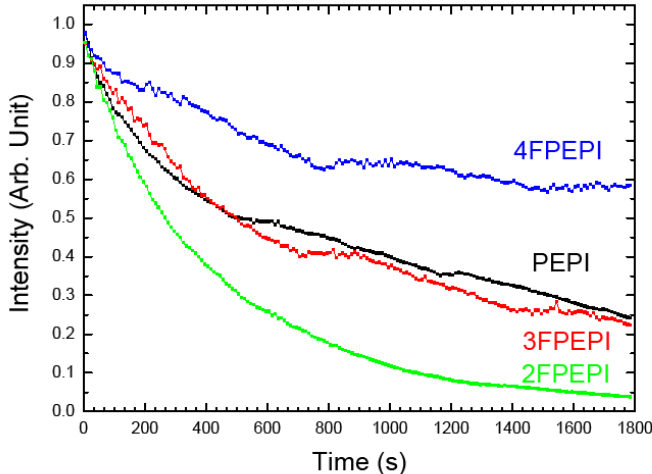
Figure 7. Evolution of PL intensity as a function of illumination time for fluorinated perovskites. The excitation source is the 325 nm line of a HeCd laser, the laser power is fixed to be 7 mW (corresponding to a fluence 0.175 W·cm −2 ).